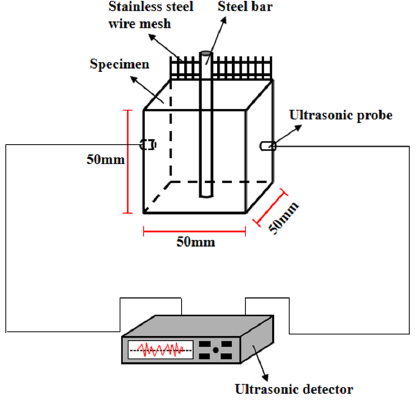
Figure 4. The ultrasonic velocity’s measurement.